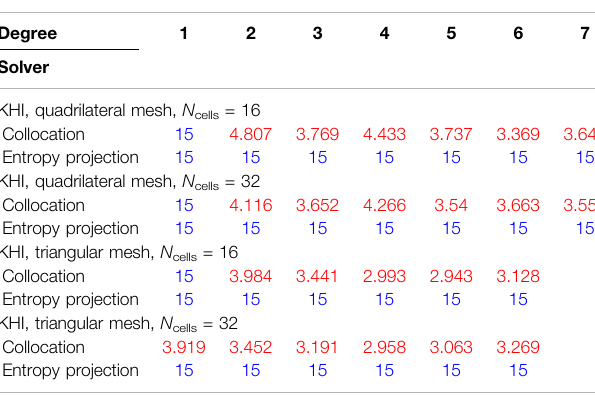
TABLE 2 | End time for simulations of the Kelvin-Helmholtz instability on quadrilateral and triangular meshes. On quadrilateral meshes, “ collocation ” refers to a nodal DGSEM discretization, while “ entropy projection ” refers to a method based on Gauss nodes. On triangular meshes, “ collocation ” refers to nodal SBP discretization, while “ entropy projection ” refers to a modal entropy stable DG